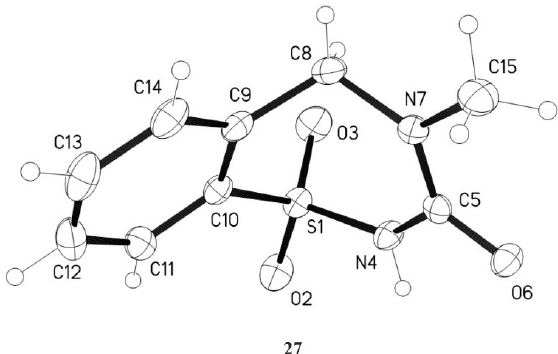
Figure 9. Molecular structure of 4-methyl-4,5-dihydro-1,2,4-benzothiadiazepin-3(2 H )-one-1,1-dioxide 27 including thermal displacement ellipses with 50% probability.